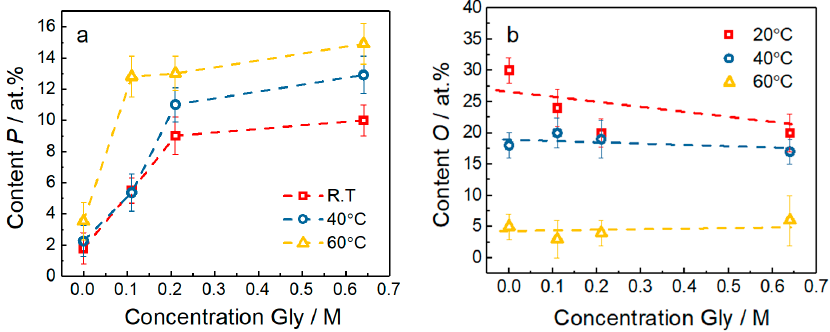
Table 1. Onset potential of the cathodic Fe-P deposition as a function of the glycine concentration Gly at 20